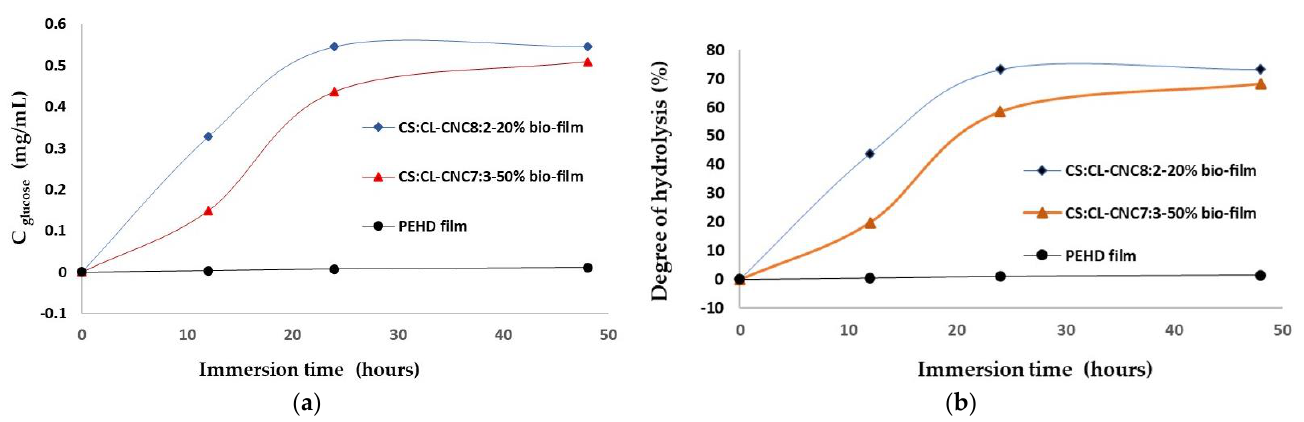
Figure 5. Kinetic bio-degradation of CL-CNC reinforced thermoplastic starch films and HDPE industrial petrochemical films as a reference: ( a ) reduced glucose concentration obtained as a function of the immersion time into the enzyme mixture, and ( b ) the degree of hydrolysis obtained as a function of the time of immersion into the enzymatic mixture.